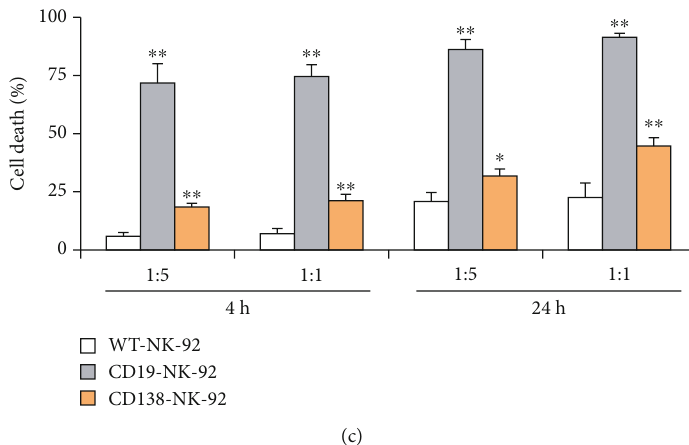
Figure 3: Dose and time pro fi les of the cytotoxicity of CD19-NK-92 and CD138-NK-92 cells toward ALL cells expressing both CD19 and CD138 antigens. (a) Flow cytometry gating strategy to speci fi cally detect cell death of PKH67-labeled target (T) cells, i.e., human ALL-derived REH cells, after incubation with e ff ector NK (E) cells, i.e., WT-NK-92 cells, by Annexin V/7-AAD assay. (b) PKH67-labeled REH cells were incubated with WT-NK-92, CD19-NK-92, or CD138-NK-92 cells at the E : T ratio of 1:5 or 1:1 for 4 – 24h, after which they were stained with Annexin V-PE and 7-AAD. Representative dot plots of Annexin V-PE versus 7-AAD in PKH67-labeled REH cells were shown. (c) Percentage of total REH cell death, comprising Annexin V-and/or 7-AAD-positive cells, was plotted. Data are mean ± s : d : ( n = 3 ). ∗ p < 0 : 05 and ∗∗ p < 0 : 01 versus WT-NK-92 cells in the same condition; two-sided Student ’ s t